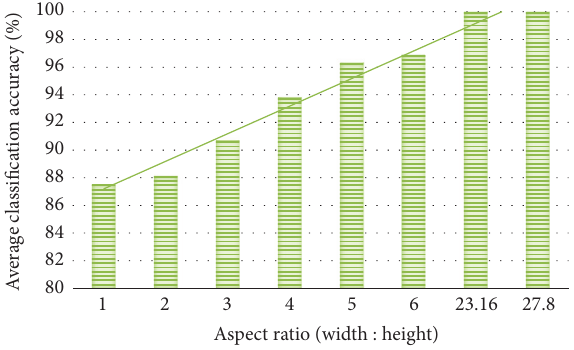
Figure 5: Effect of the vibration image aspect ratio on average classification